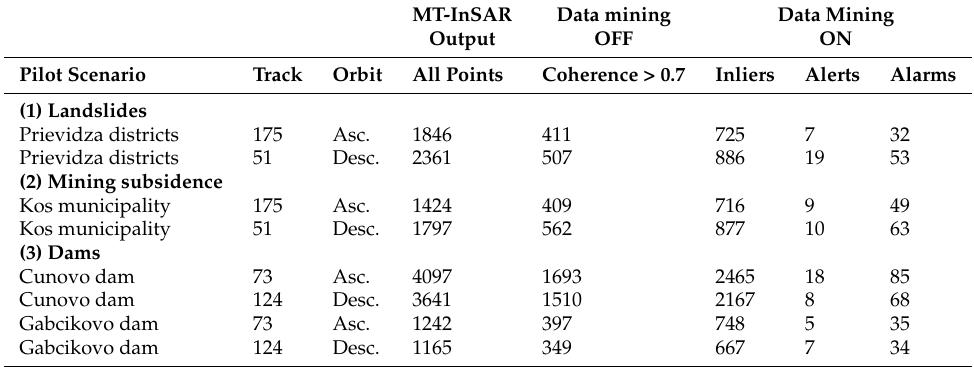
Table 6. Summary of point counts for filtered deformation